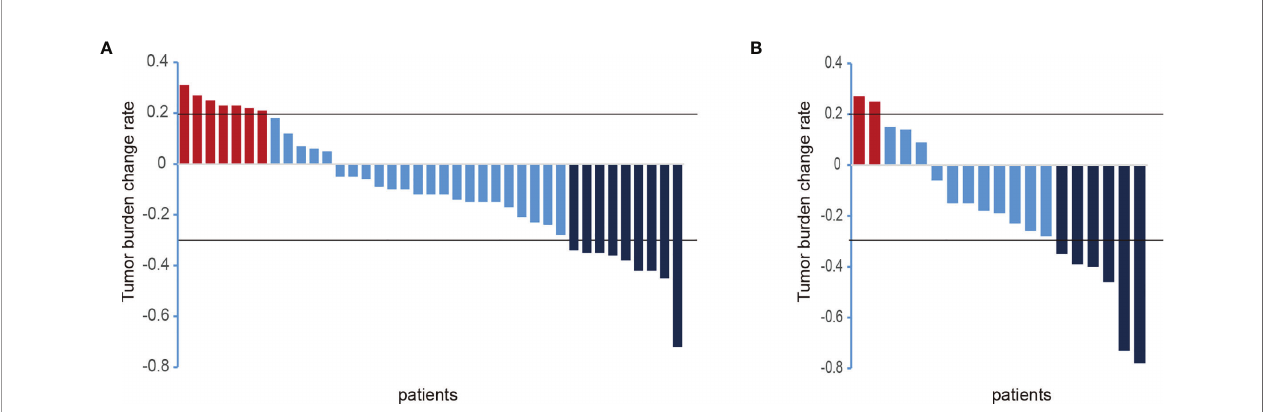
FIGURE 2 | Changes of intrahepatic lesions in the included patients after systemic treatment. [ (A) TKIs group; (B) TKIs + ICIs group; PD, progressive disease; PR, partial response partial remission; ordinate, the sum of the maximum diameter of the tumor target lesion; abscissa, all patients included in this